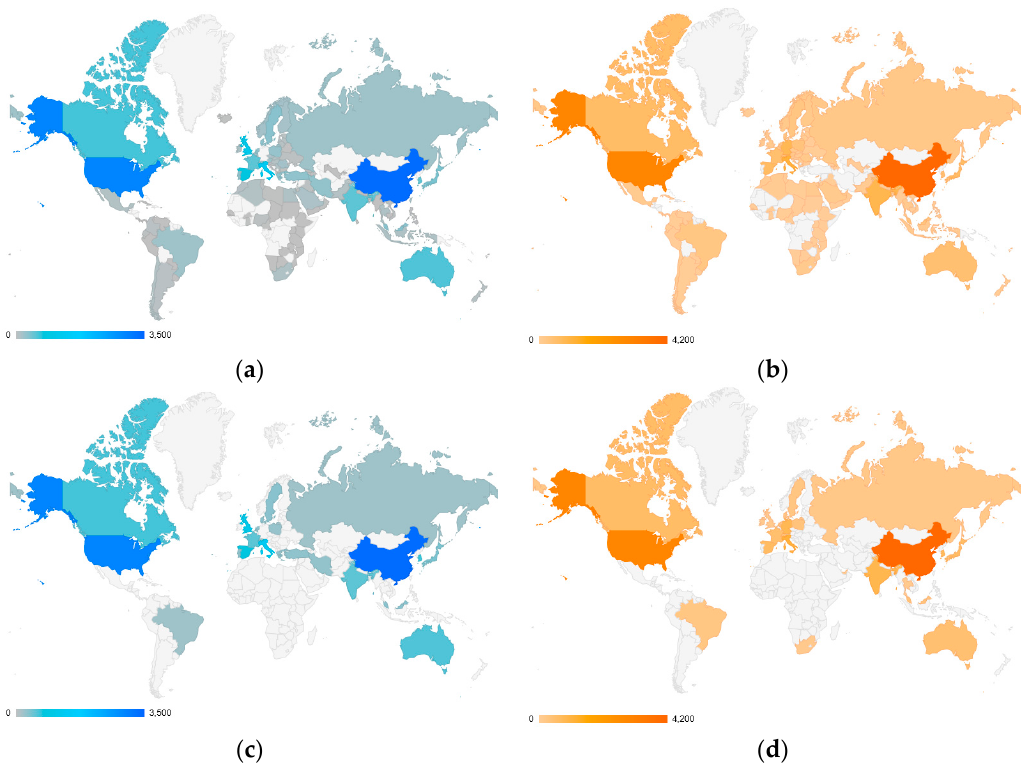
Figure 4. Geographical distribution of the documents studied: ( a ) Web of Science; ( b ) Scopus; ( c ) 25 countries with the greatest number of publications in Web of Science; and ( d ) 25 countries with the greatest number of publications in Scopus.